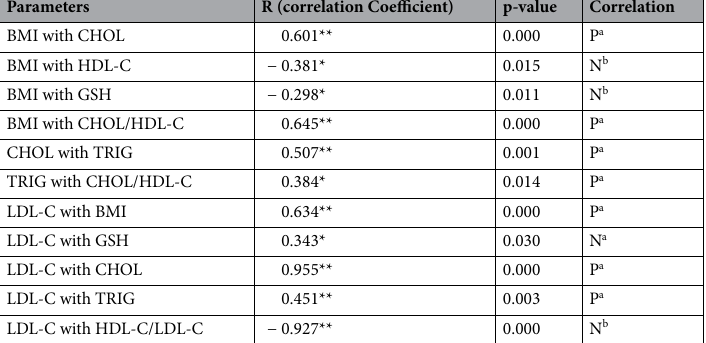
Table 5. Pearson’s correlation coefficients between measured variables. ** p < 0.01. * p < 0.05. a Positive correlation. b Negative